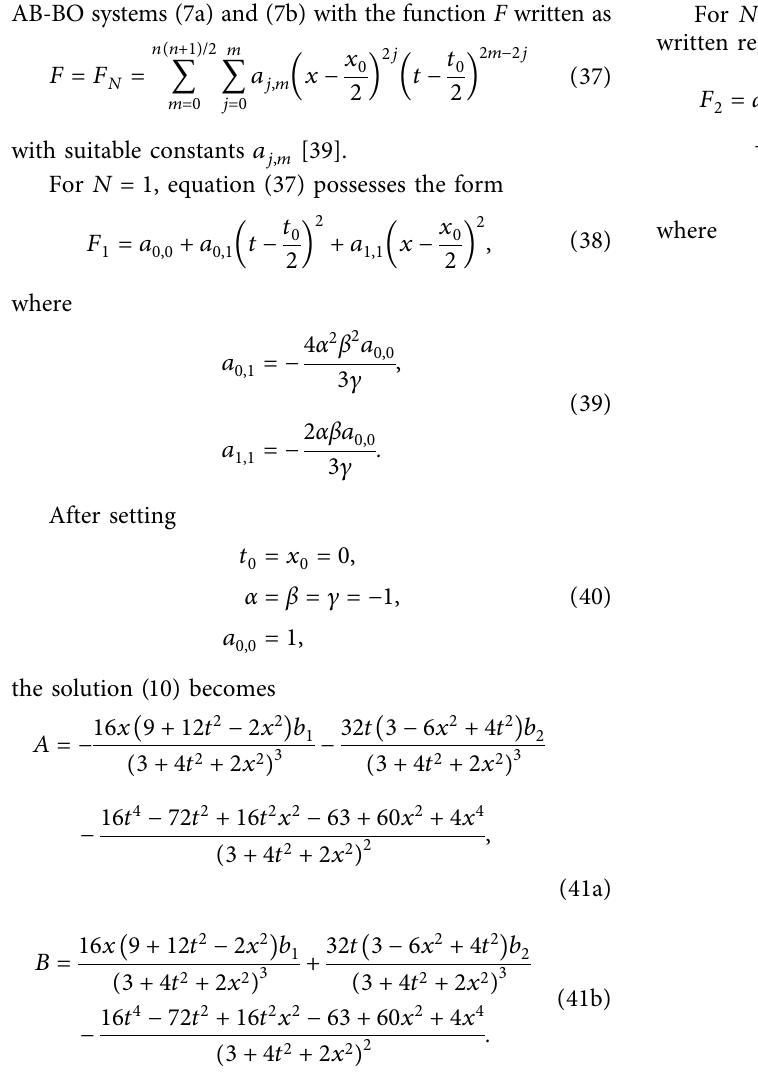
� b � 0; (b) and (c) b 1 2